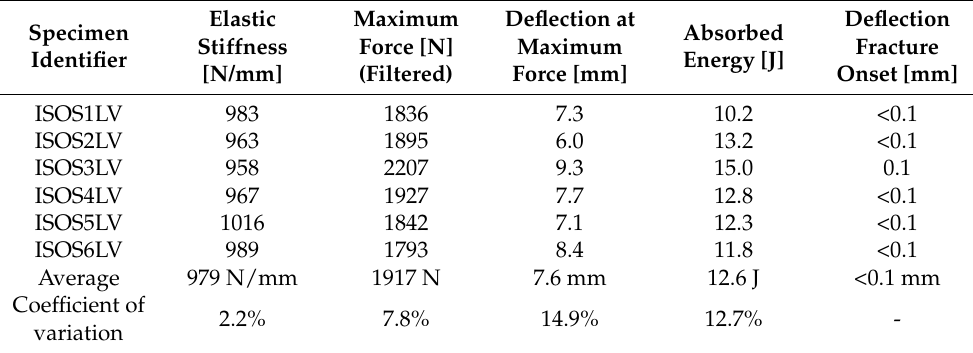
Table 6. Summary of low-velocity puncture mechanical